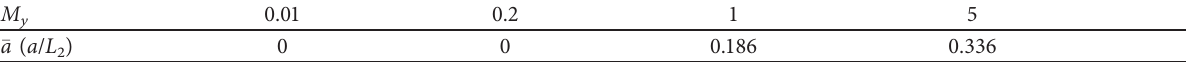
Table 4: Average crack lengths with different material shapes ( t �